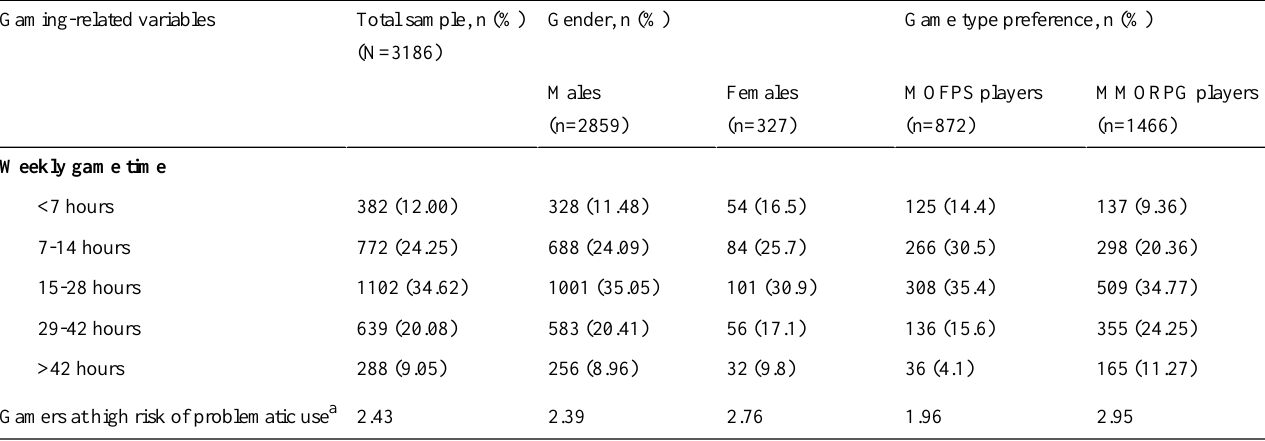
Table 1. Weekly game time and proportion of gamers at high risk of problematic use for the overall sample, for males and females, and for multiplayer online first-person shooter (MOFPS) and massively multiplayer online role-playing games (MMORPGs) gamer types.